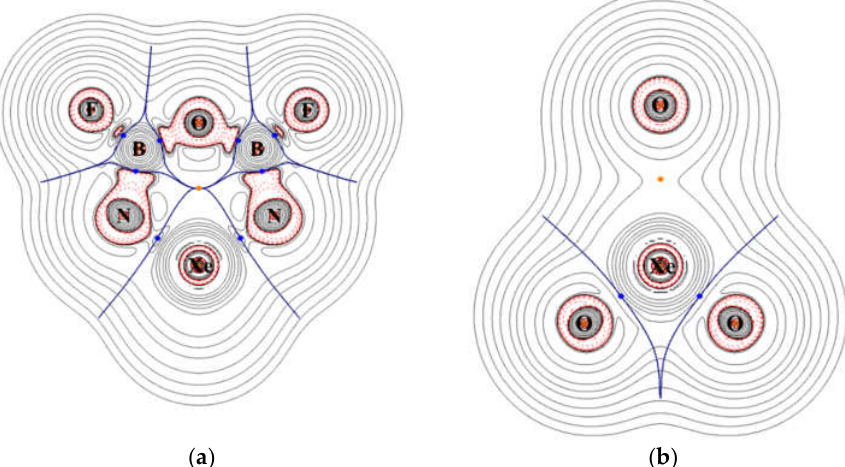
Figure 7. Contour plots of the calculated Laplace concentration of XeO 3 N 2 B 2 F 2 on ( a ) the ring plane ( b ) the XeO 3 plane. The red contour lines are in regions of charge concentration and the black contour lines are in regions of charge depletion. The blue lines pass points of zero gradients, and the dots are bond critical points.